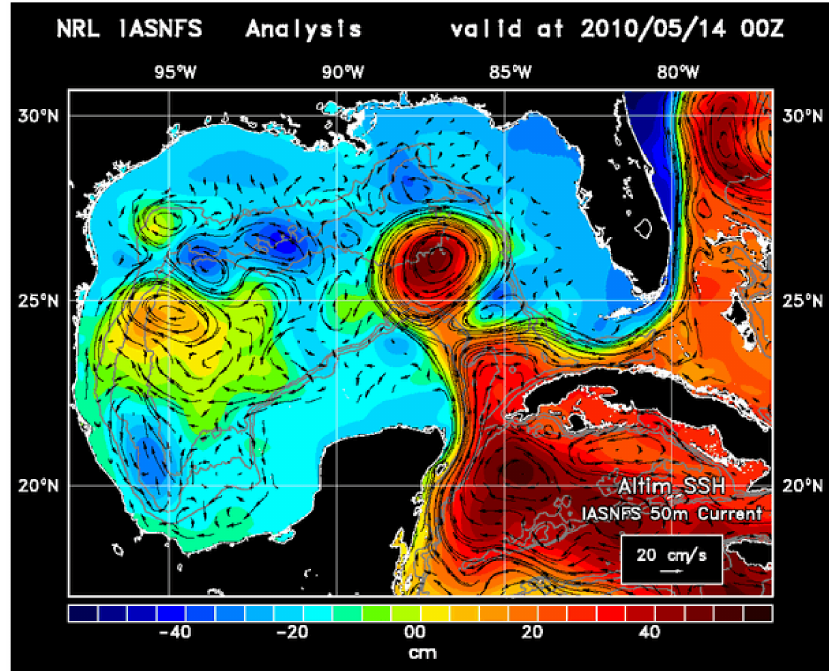
Figure 3. This shows the IASNFS reanalysis water currents below the surface boundary layer at 50-m depth (in black vectors) superimposed over color-coded satellite altimeter SSH for May 14, 2010. This analysis indicates that the IASNFS current follows the altimeter SSH remarkably well, even when the GOM Loop Current was evolving rapidly (from